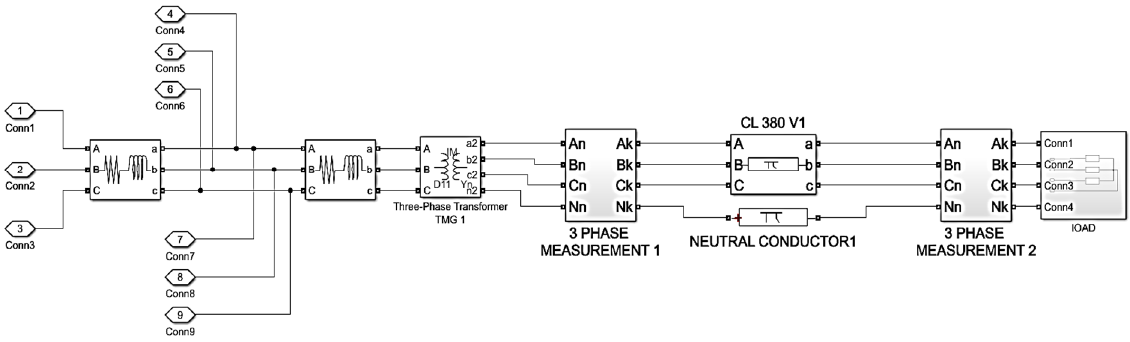
Figure 4. Model of the section of the city electrical network.